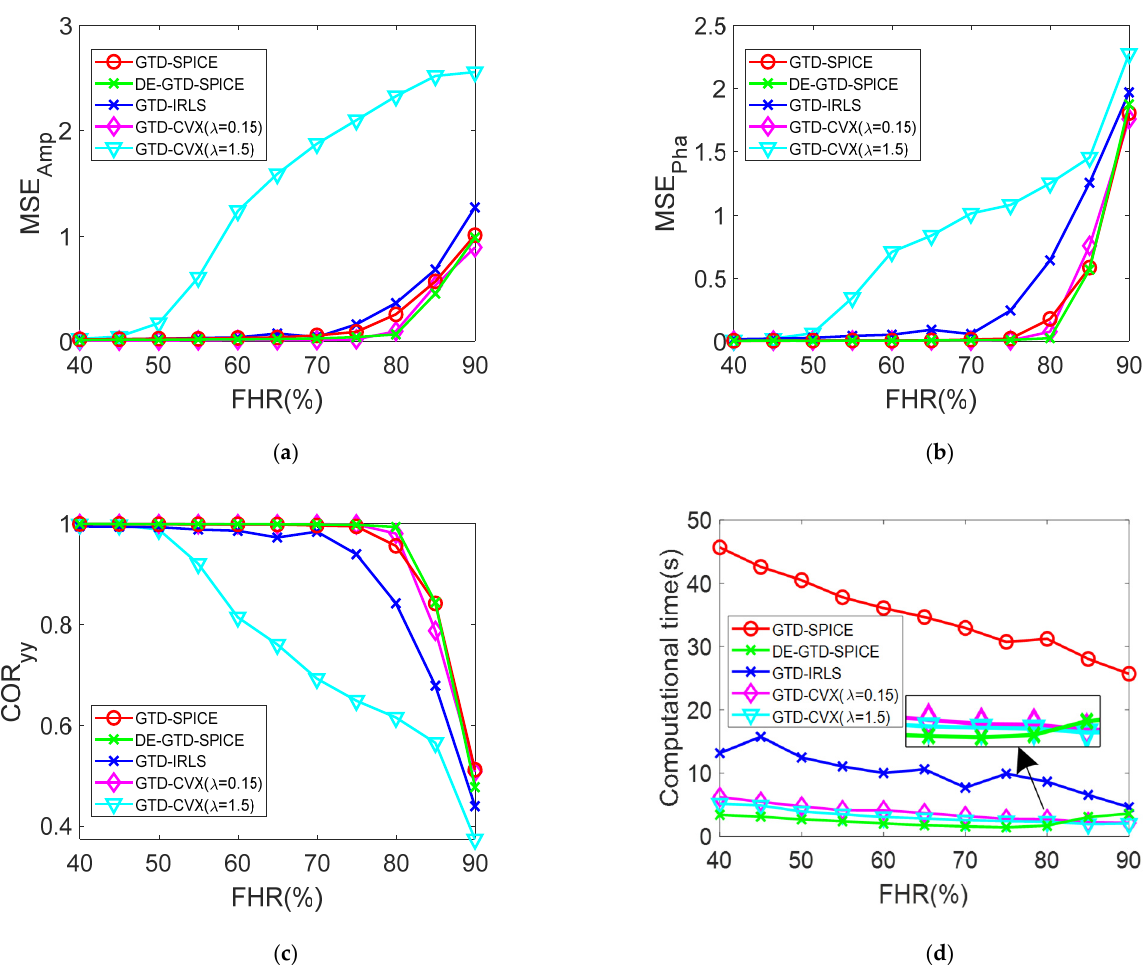
Figure 9. Comparison on ( a ) MSE of the amplitude of the reconstructed RCS sequence, ( b ) MSE of the phase of the reconstructed RCS sequence, and ( c ) the correlation coefficient versus the FHR . ( d ) Computational time versus the FHR.